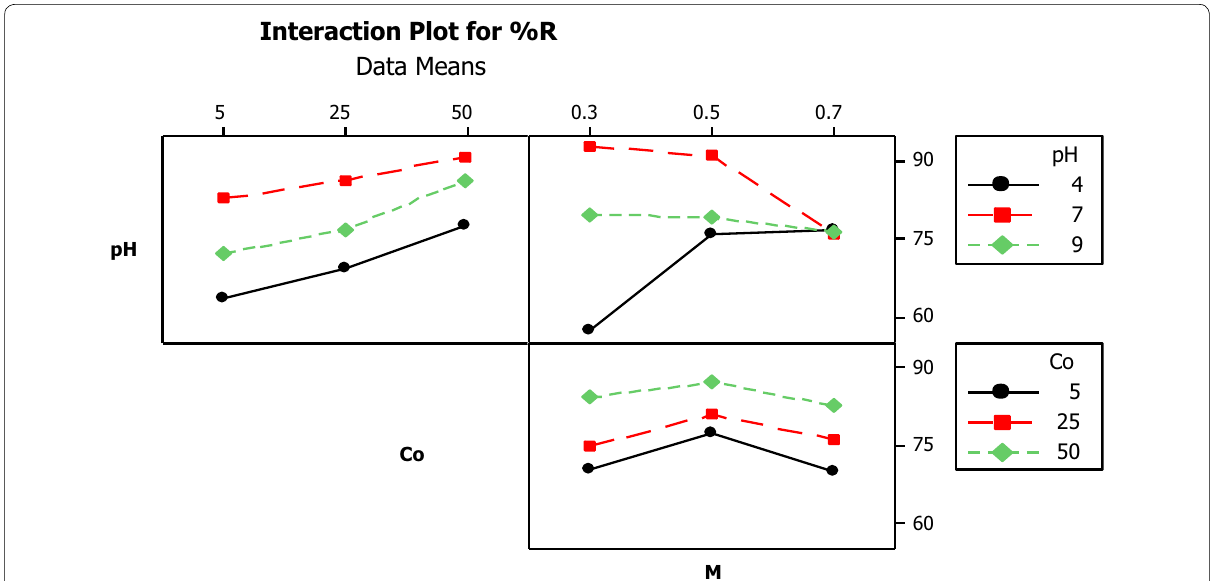
Fig. 4 Interaction of parameter in the bisacodyl adsorption process, the lines are not parallel. It represents some evidence for effective interactions between the parameters. The significant interaction between pH and adsorbent dose observed in the bisacodyl adsorption process